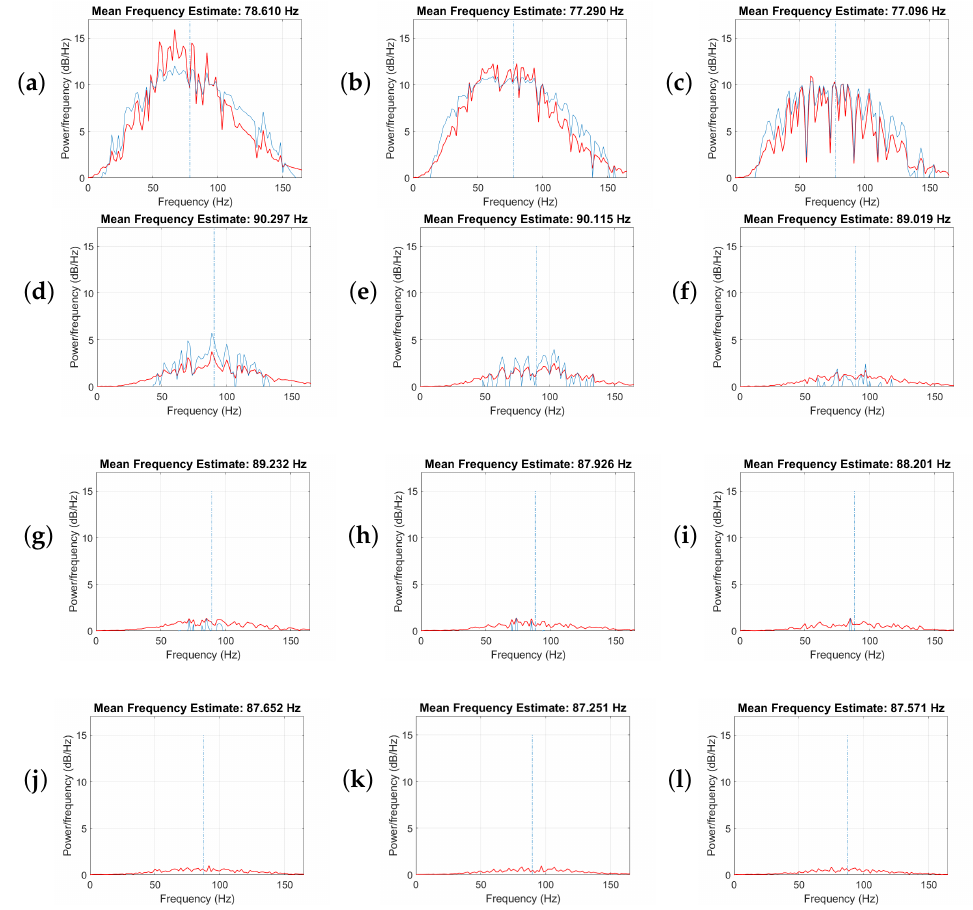
Figure 5. Analysis of the power spectrum for each singular value. Panels ( a – l ) show the power spectrum recovered by the 1st to 12th singular values,